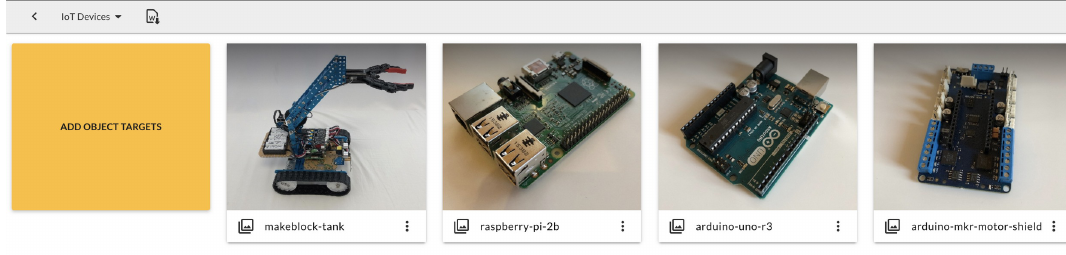
Figure 10. List of objects in the